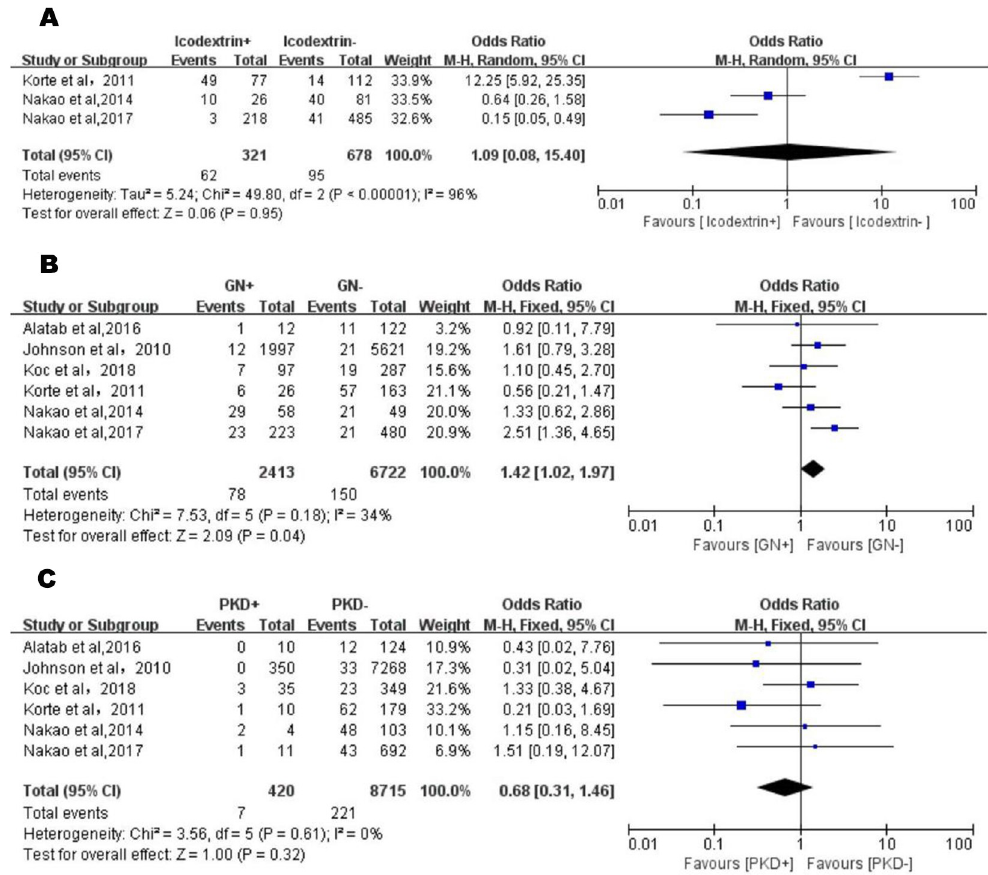
Fig 4. A. Forest plot of use of icodextrin and EPS in the exploratory meta-analysis. The odds ratio and 95% CI for each study and the final combined results are displayed numerically on the left and graphically as a forest plot on the right. B. Forest plot of GN and EPS in the exploratory meta-analysis. The odds ratio and 95% CI for each study and the final combined results are displayed numerically on the left and graphically as a forest plot on the right. C. Forest plot of PKD and EPS in the exploratory meta-analysis. The odds ratio and 95% CI for each study and the final combined results are displayed numerically on the left and graphically as a forest plot on the